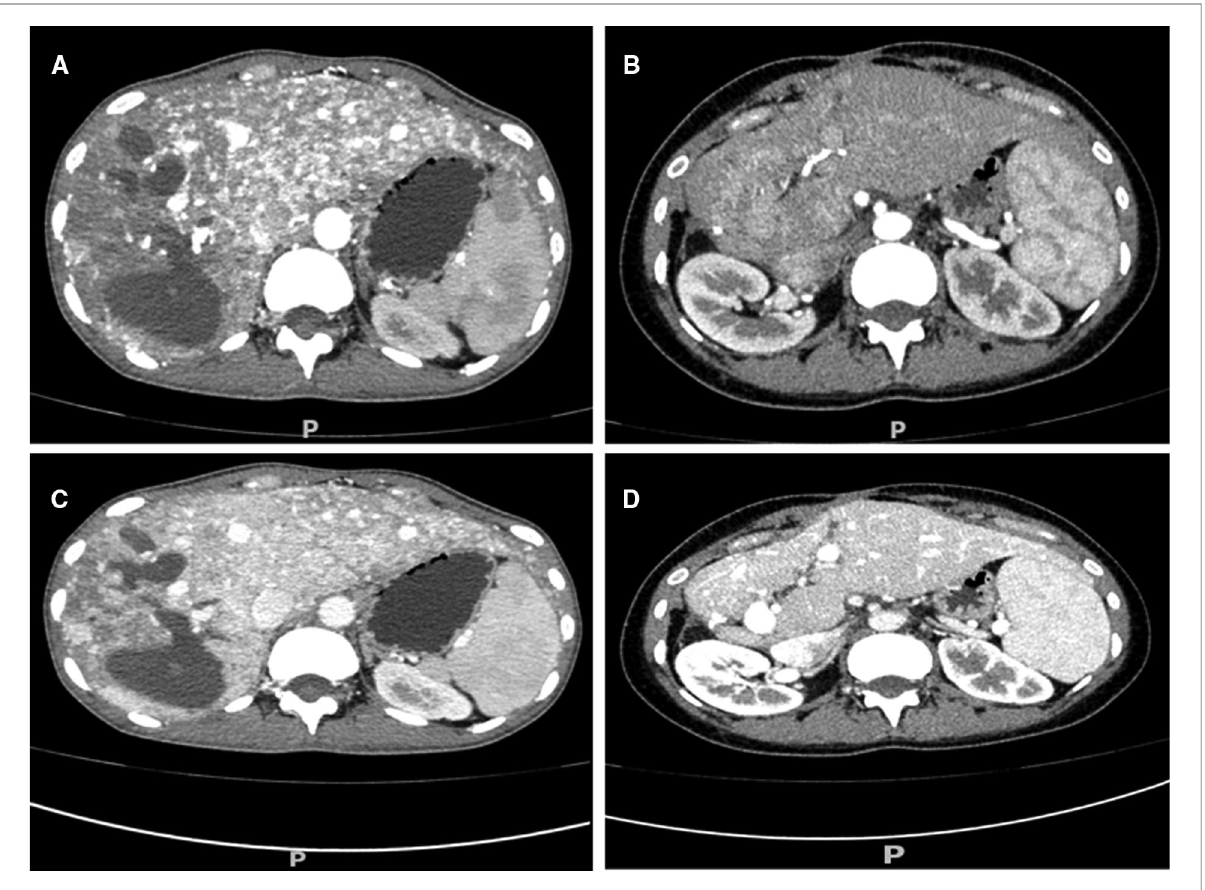
FIGURE 4 CT image comparison of the hepatic arteriovenous shunt before and after operation. CT arterial phase showed a signi fi cant decrease in telangiectasia and the shunt ( A , preoperative; B , postoperative). Enhanced CT in the portal phase also showed a signi fi cant decrease in the shunt ( C , preoperative; D ,